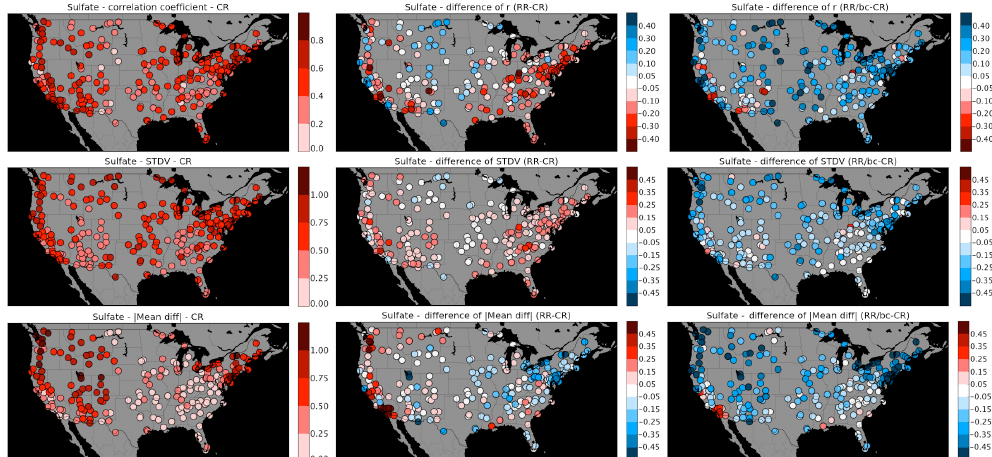
Fig. 7. Same as Fig. 5 but for daily averaged sulfate surface concentrations.